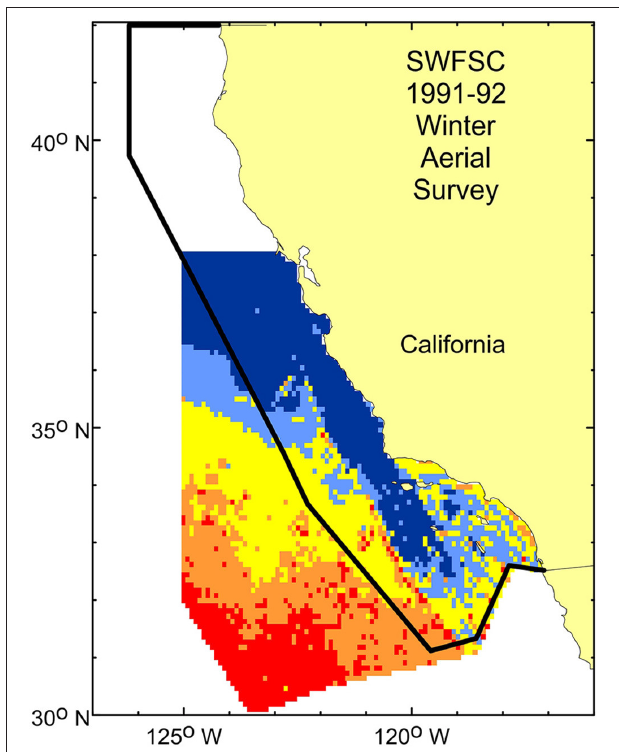
FIGURE 6 | Multi-year average density predictions from the short-beaked common dolphin model shown in Figure 4A overlaid on the Forney and Barlow (1998) aerial survey study area (black solid line), showing that the western edge of the study area is east of the offshore mid- to high-density region identified in this study and noted by Campbell et al. (2015).